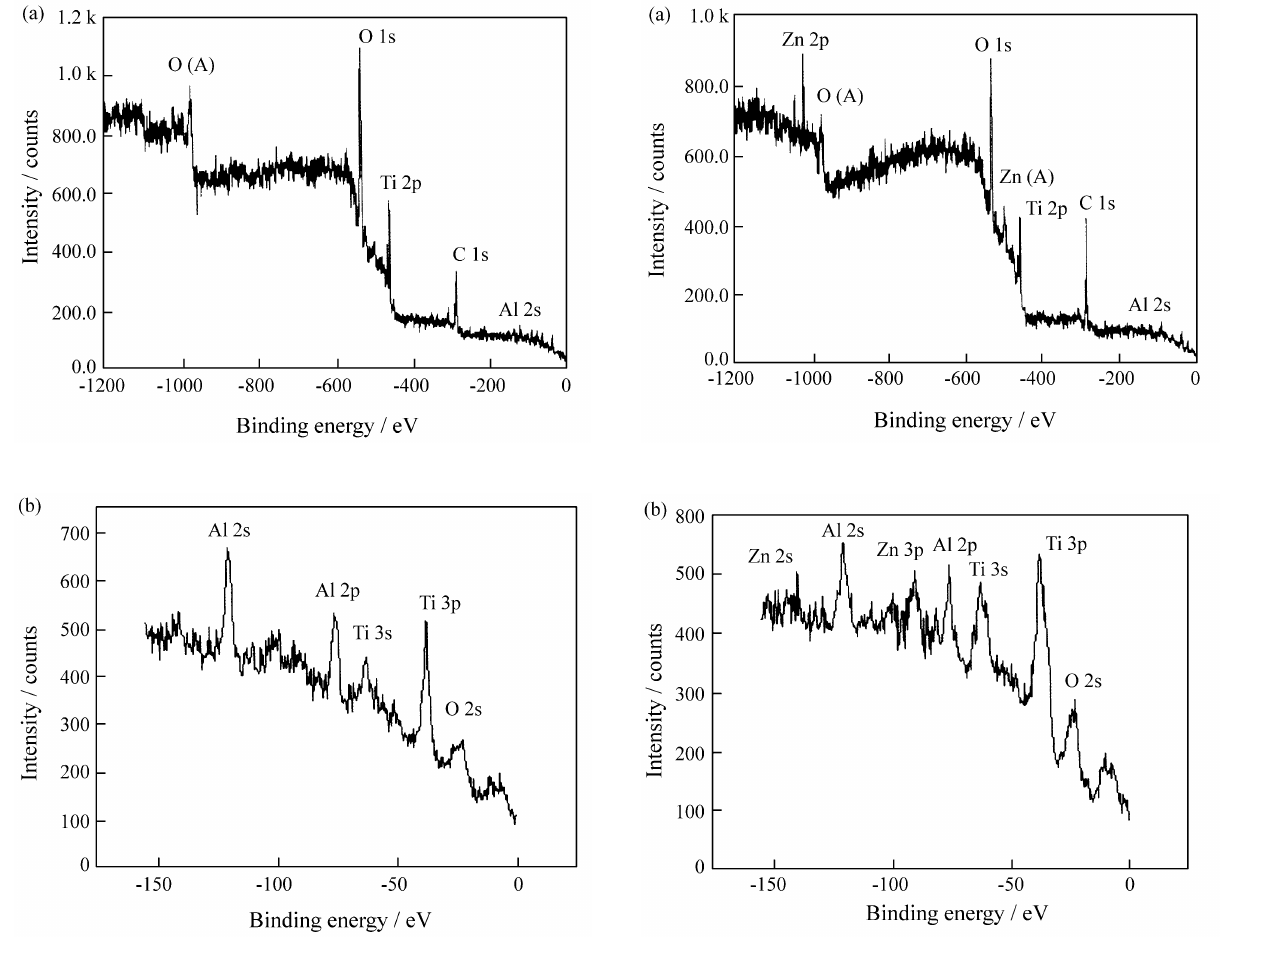
Figure 7. XPS spectra for sample plasma-sprayed with titanium. a) general view; b) details near Al